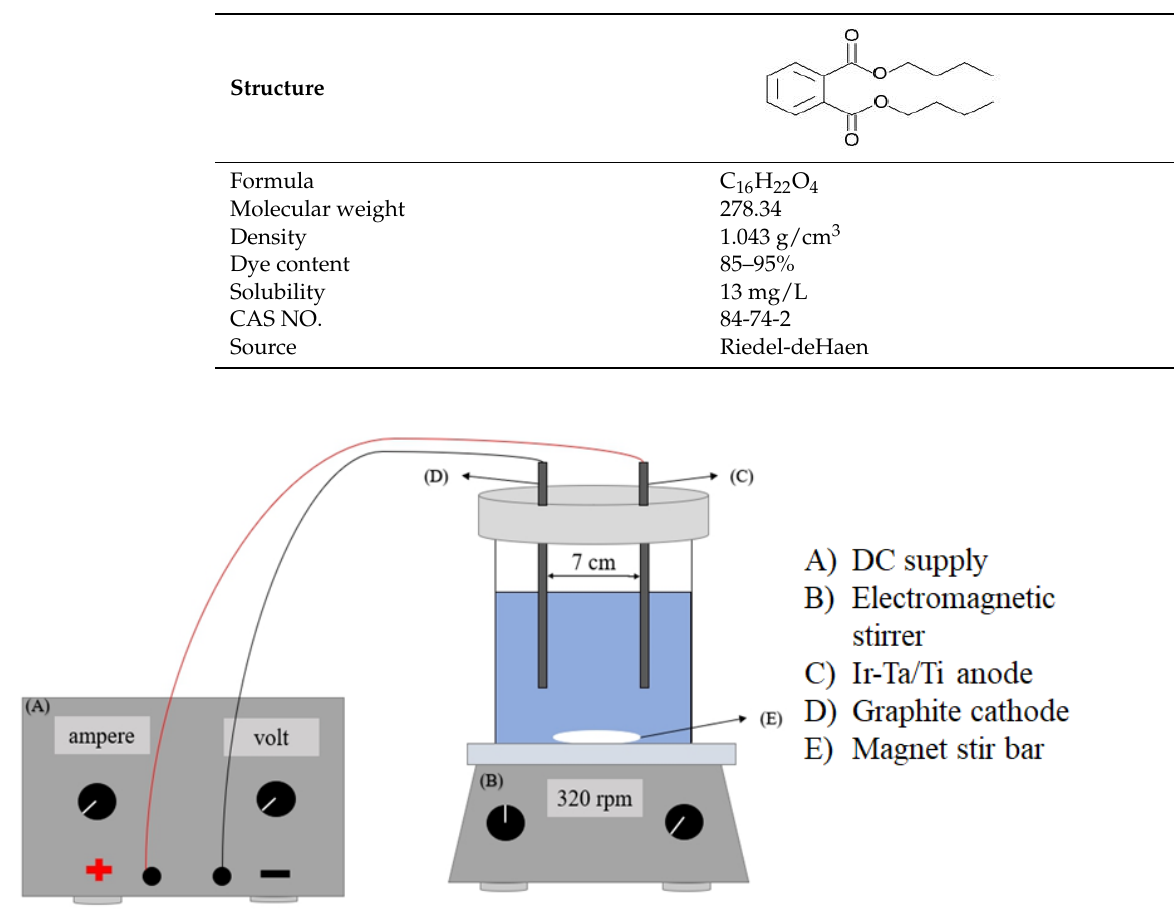
Figure 8. Schematic diagram of the electrocatalytic system.